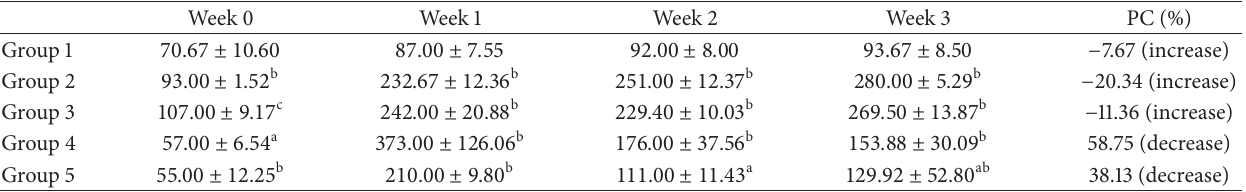
Table 1: Fasting blood glucose of diabetic and nondiabetic rats